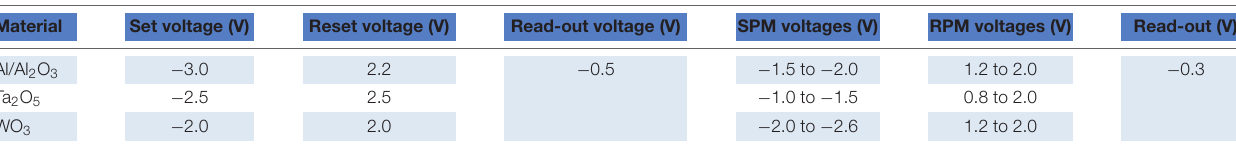
FIGURE 1 | (A–C) I-V curves for three different materials, (B) Al/Al 2 O 3 , (C) Ta 2 O 5 , and (D) WO 3 , like it is indicated by the layer stack in the lower right corner. The voltage is applied on the top electrode. For every device, three different sizes—100 × 100, 50 × 50, and 20 × 20 µ m 2 —are measured. The red dotted line indicates the read out voltage for the area scaling. The switching voltages differ between the three stacks: (A) Al 2 O 3 : 2.2 V/–3 V, (B) Ta 2 O 5 : ± 2.5 V, and (C) WO 3 : ± 2 V. (D–F) Area dependence of the LRS and HRS. The resistance value is scaling with the device size, for all of the three materials, (D) Al 2 O 3 , (E) Ta 2 O 5 , and (F) WO 3 . The slopes of the linear fit for all of the devices and the HRS and LRS are around –1 (cid:127) / µ m 2 . Slopes can be seen in Table 2 . TABLE 1 | Voltages for the conducted